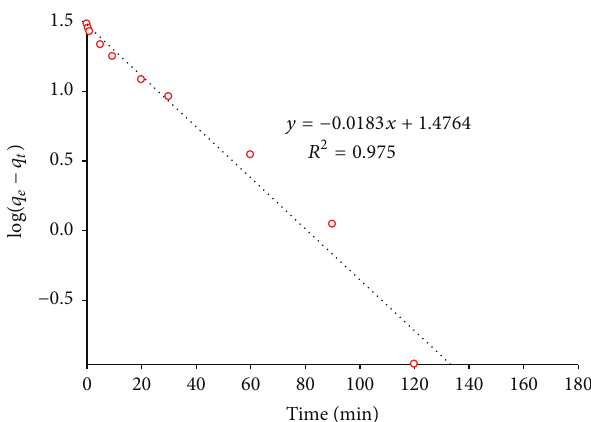
Figure 13: Pseudo-first-order plot for adsorption of copper ions onto CaHBSW.